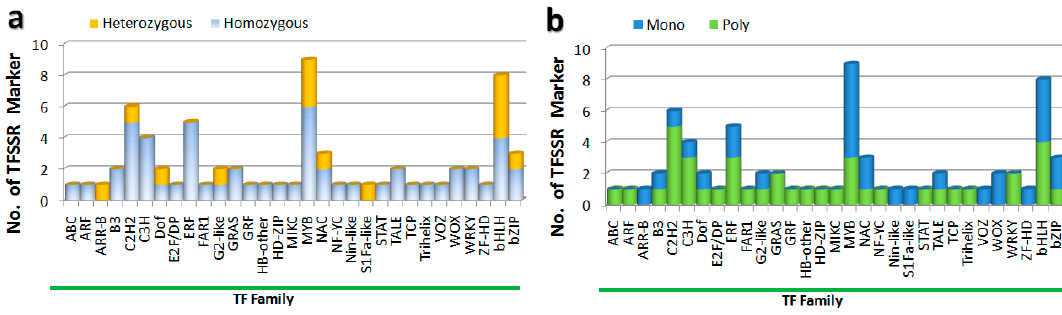
Figure 3. Experimental evaluations of TFSSR markers for 31 TF families. ( a ) Evaluation of homozygosity and heterozygosity by TF family; ( b ) Evaluation of mono and polymorphism by TF family.